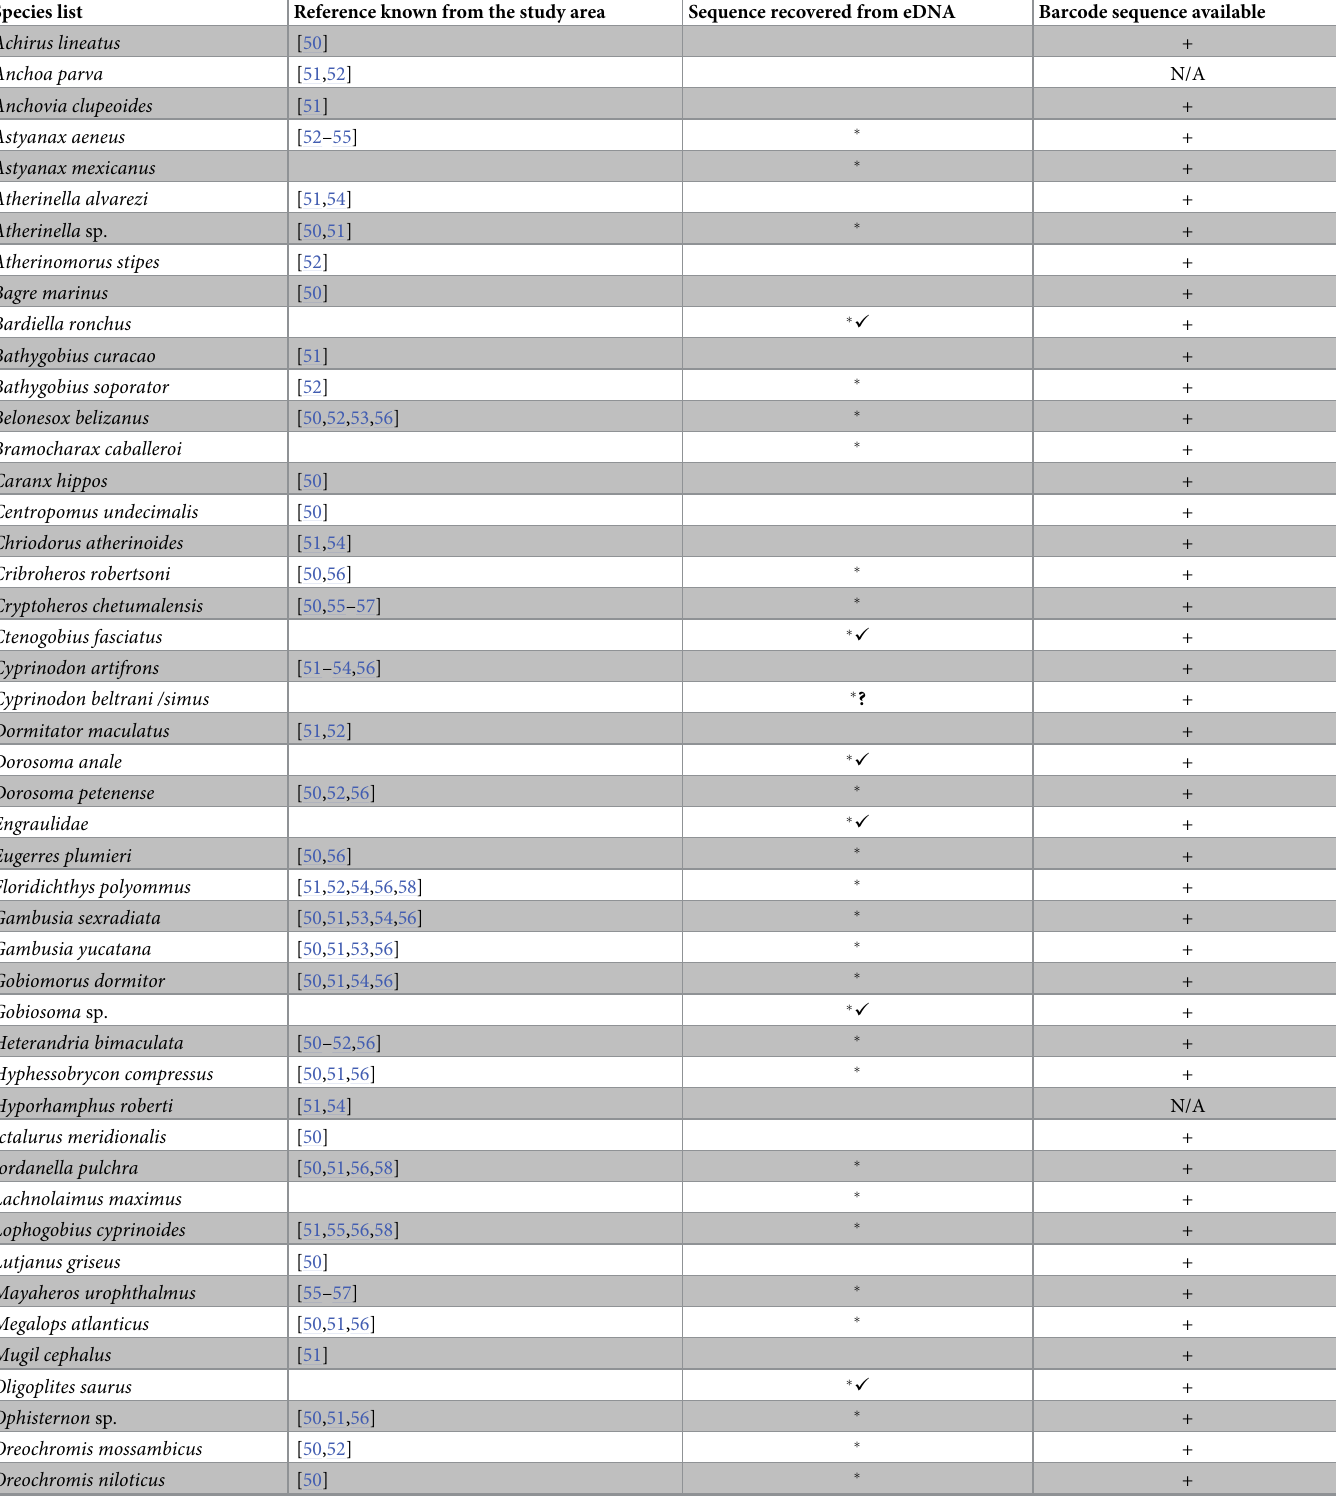
Table 2. Fishes that were detected in eDNA, known from the literature [with references in brackets] and those with barcodes. Species